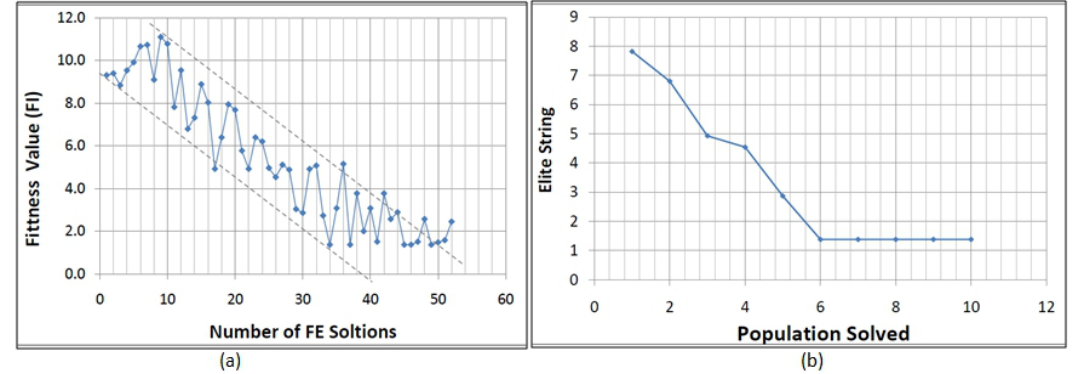
Figure 5: (a) Variation of FI value (b) Convergence of GA Objective Function